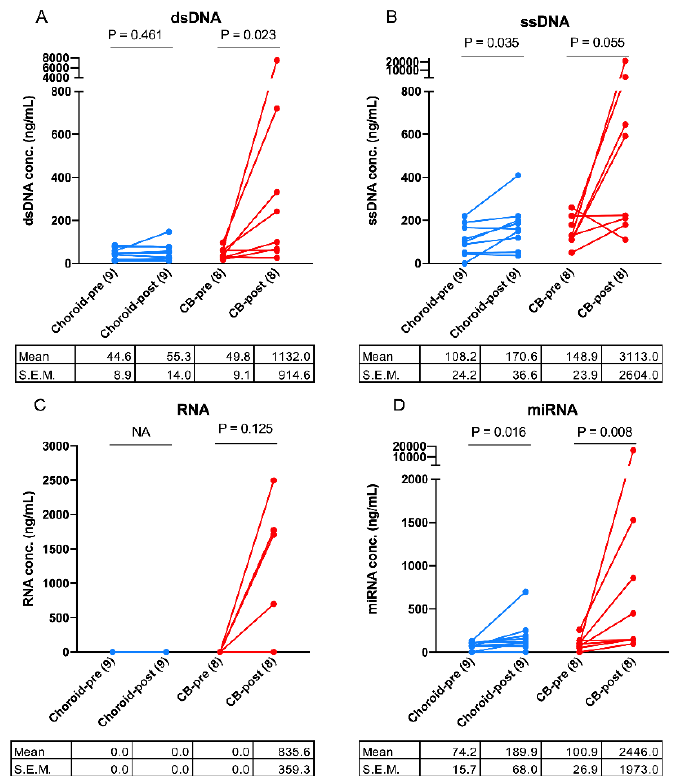
Figure 1. Quantification of cell-free nucleic acids in UM aqueous humor samples before (pre-) and after (post-) radiation. Concentration of ( A ), double-stranded DNA (dsDNA), ( B ), single- stranded DNA (ssDNA), ( C ), RNA and ( D ), microRNA (miRNA), were determined in 18 (9-paired) choroidal melanoma (choroidal) and 16 (8-paired) ciliary body (CB) melanoma AH samples. AH samples were grouped by collection time at pre- and post-radiation. P values were calculated by paired t-test. Mean and standard error of the mean (S.E.M.) were indicated. NA, not-available.